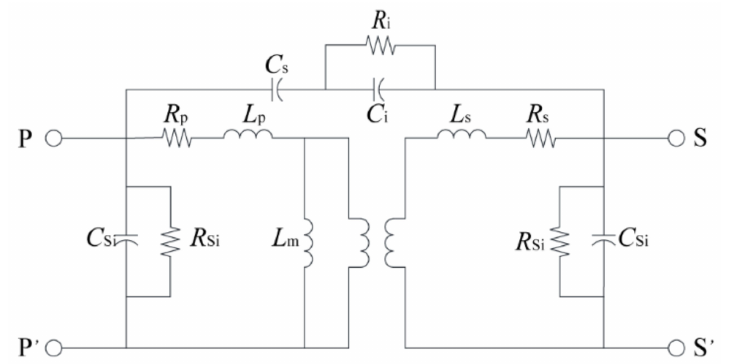
Figure 2. Equivalent circuit model of the 3D in-chip